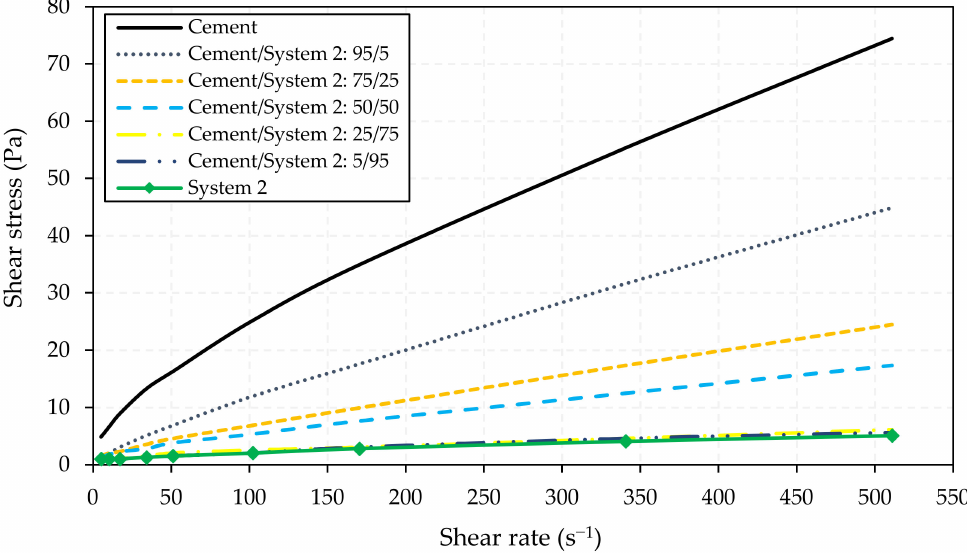
Figure 9. Rheological behavior of cement slurry / cleanup fluid mixture (system 2) and pure